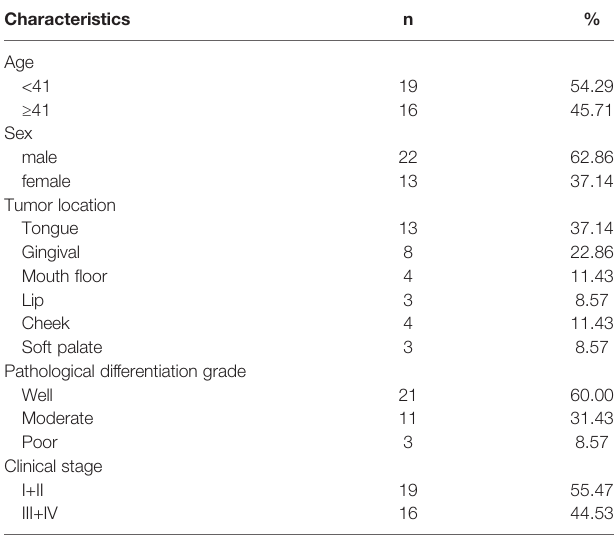
TABLE 1 | The clinical characteristics of OSCC patients.